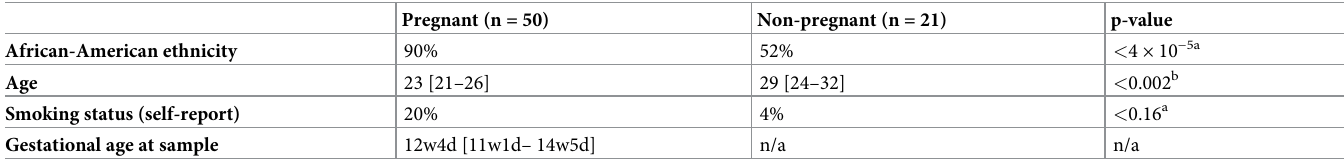
Table 1. Characteristics of the study